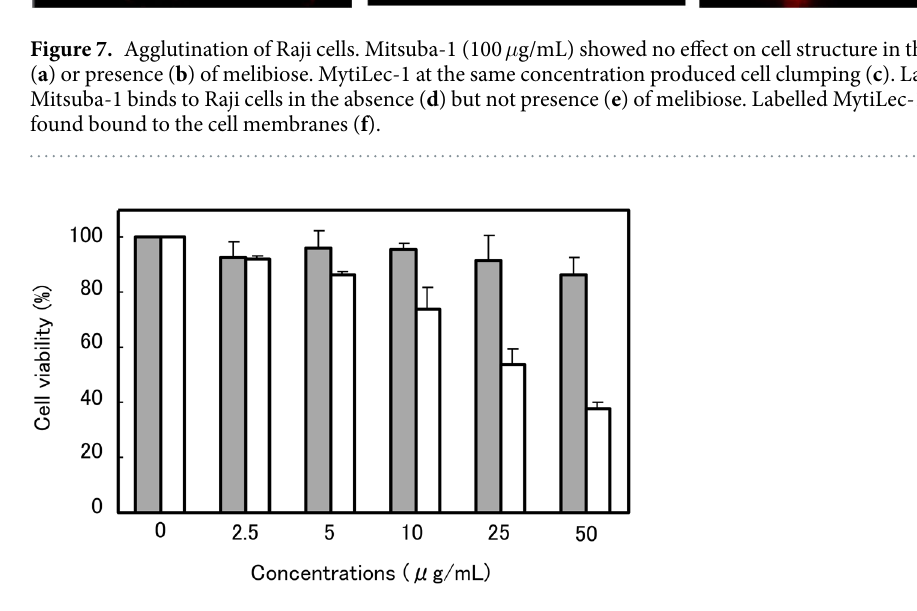
Figure 8. Cytotoxicity assay. MytiLec-1 and Mitsuba-1 were applied to Raji cells at concentrations up to 50 μ g/ mL, and cell viability assessed after 48 h incubation at 37 °C. MytiLec-1 (white bars) showed a marked effect on cell survival rate, but Mitsuba-1 (grey bars) gives no significant drop in